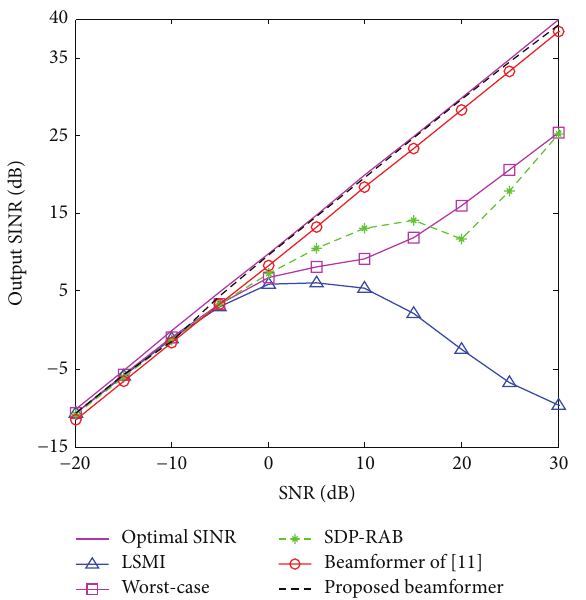
Figure 9: Output SINR of beamformers versus input SNR for the case of perturbations in antenna array